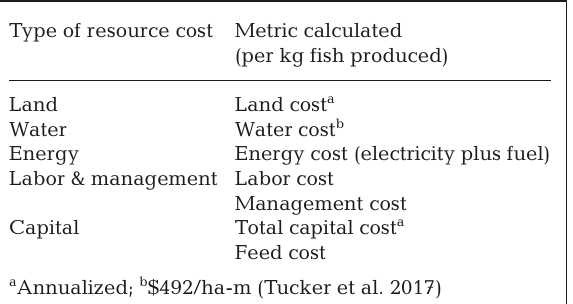
Type of resource cost Metric calculated (per kg fish